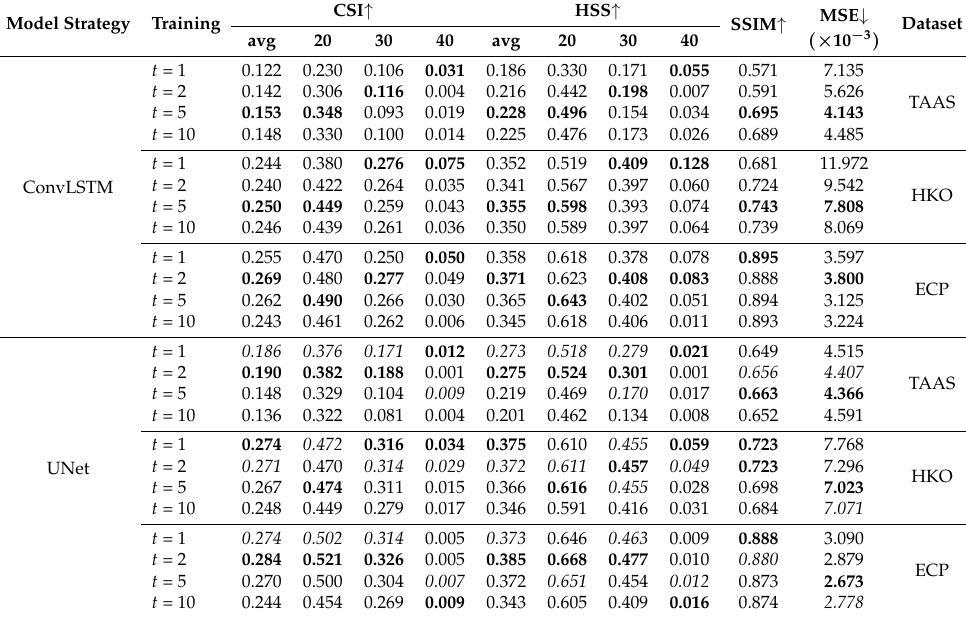
Table 7. Performance with different t s.